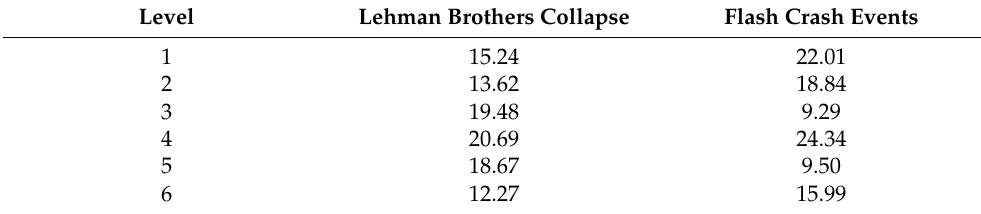
Table 3. Power spectra for XOM stock market data.